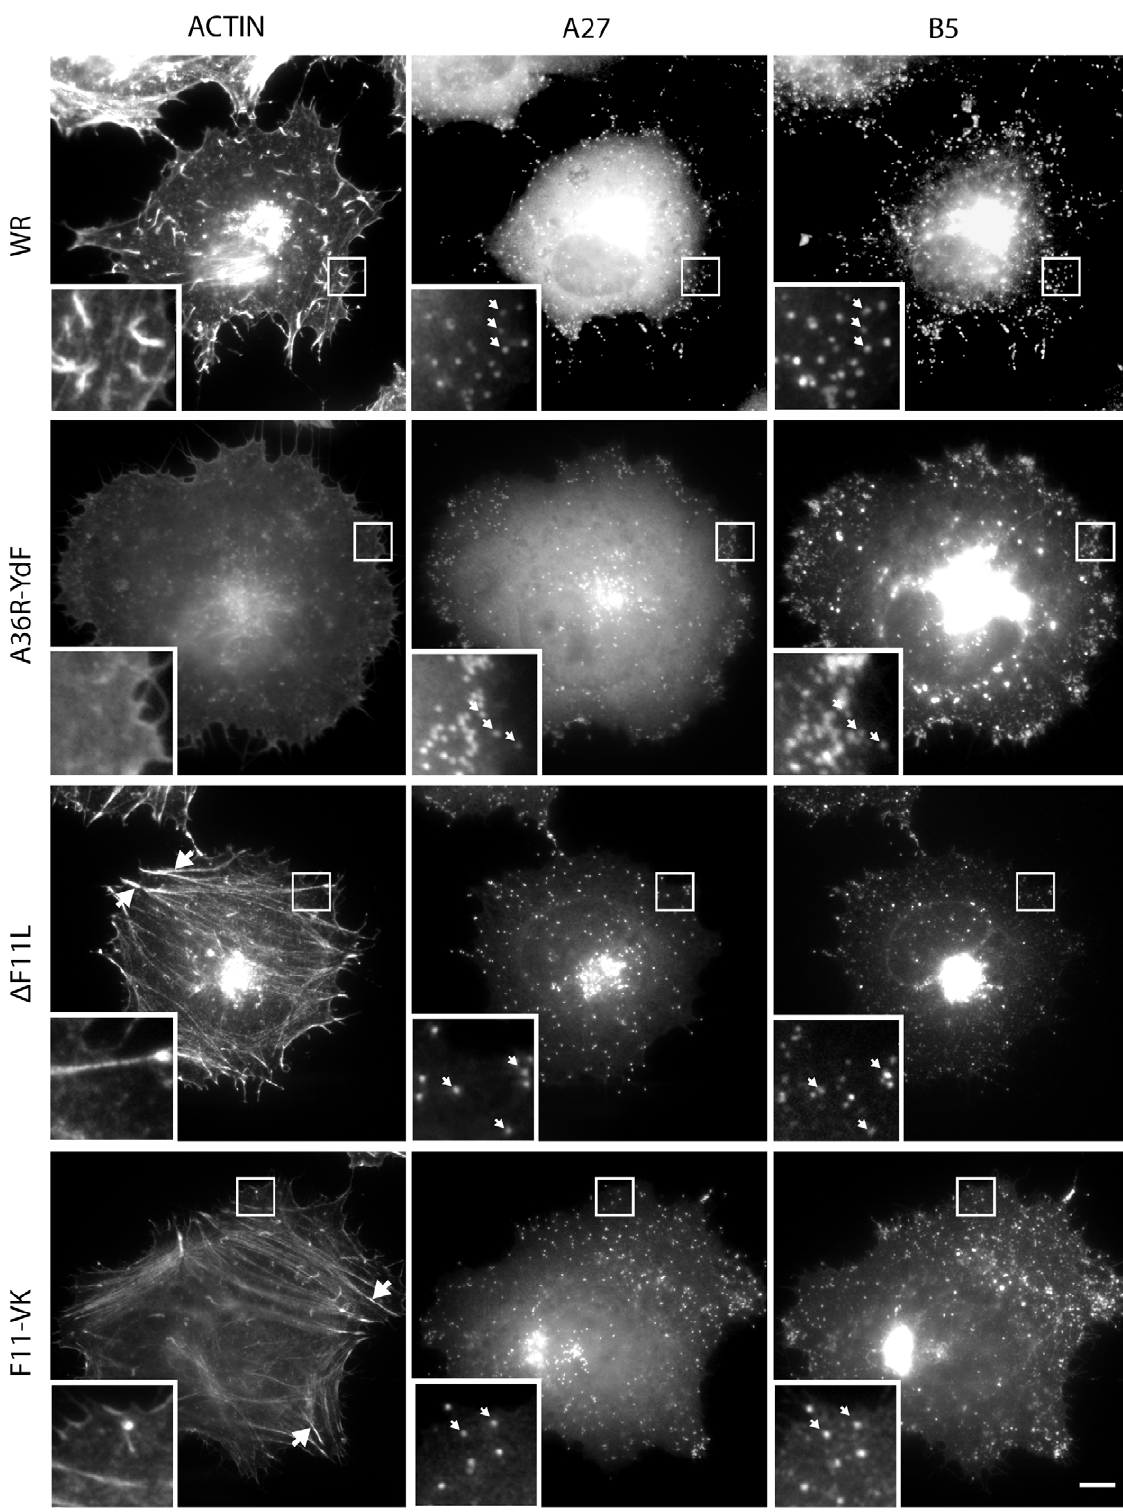
Figure 1. F11 promotes loss of actin stress fibres during infection. ( A ) Representative images of infected HeLa cells stained with the viral markers A27 and B5 reveals that loss of F11or its ability to bind RhoA (F11-VK) does not affect virus particle assembly (white arrow heads in inserts). The presence of actin stress fibres (large white arrows) in D F11L and F11-VK but not WR or A36R-YdF infected cells is indicative of active RhoA signalling. Scale bar=10 m m.